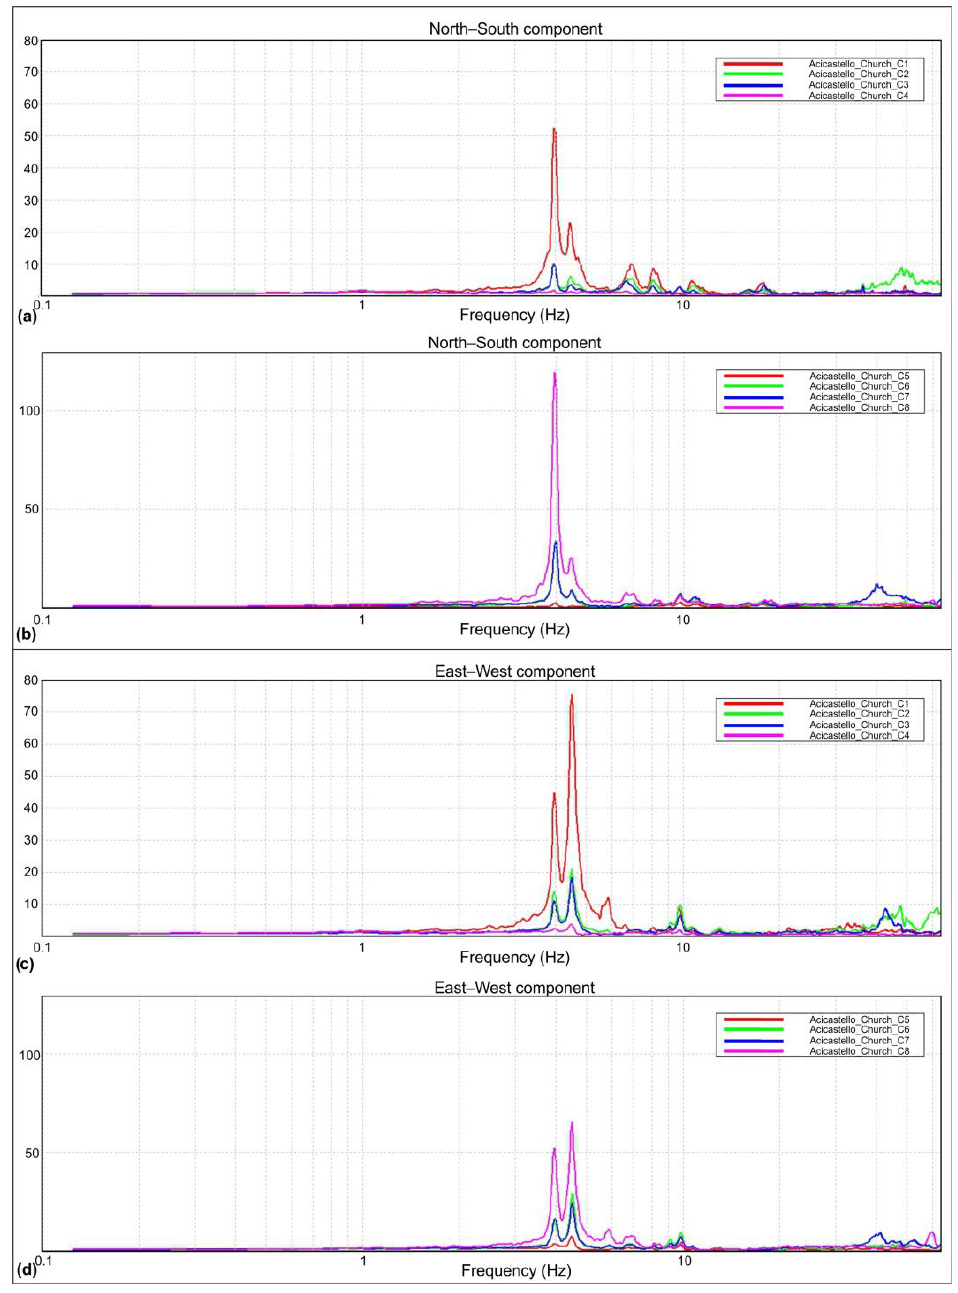
Figure 10. Averaged spectral ratios for Vertical n. 1 ( a ) and Vertical n. 2 ( b ) in the N – S direction; averaged power spectra for Vertical n. 1 ( c ) and Vertical n. 2 ( d ) in the E – W direction.